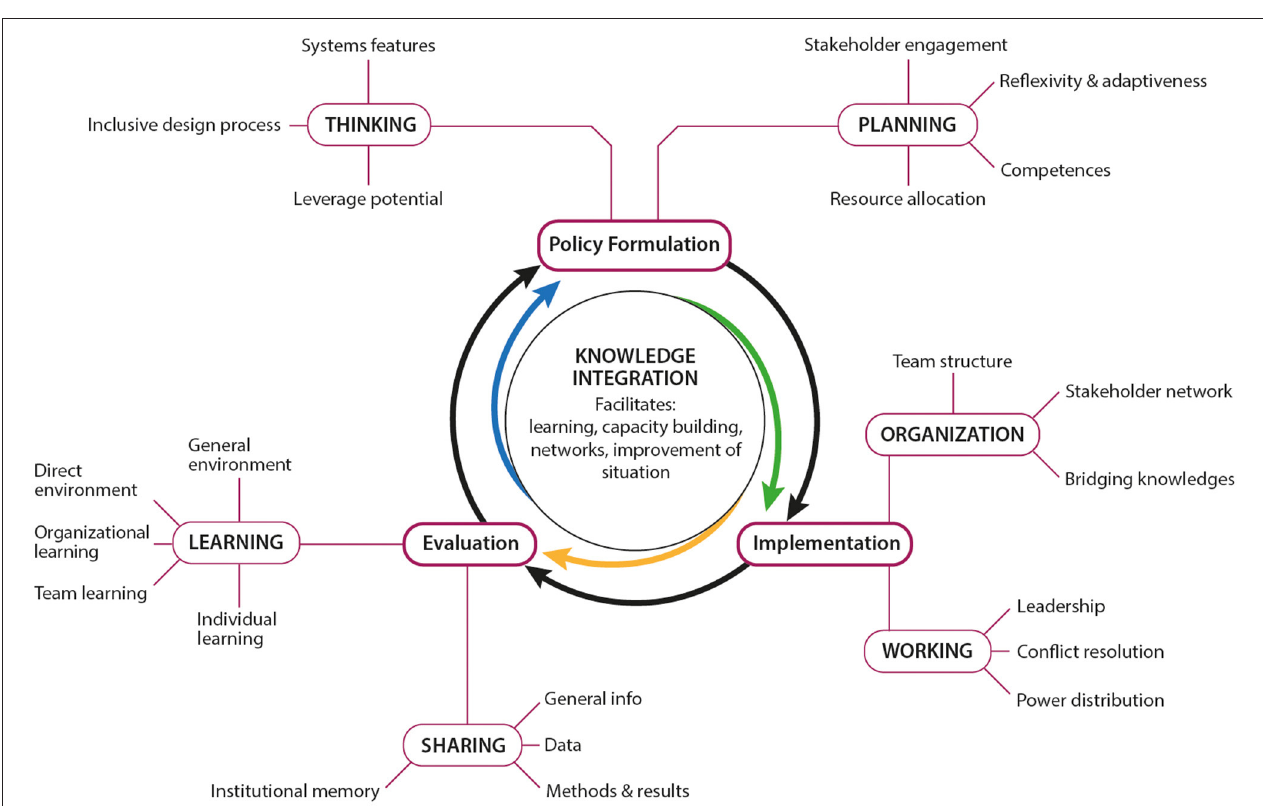
FIGURE 1 | Structure of the EVOLvINC tool for Evaluating knOwLedge Integration Capacity in multi-stakeholder governance according to Hitziger et al. (13). The bold black cycle contains the three stages of the project life cycle (formulation, implementation, and evaluation). The knowledge integration capacity in each of these stages is assessed by two aspects (bold, capital letters), and each aspect is measured by 3–5 criteria. The questions attributed to each criterion in the EVOLvINC tool are stated in Table 3